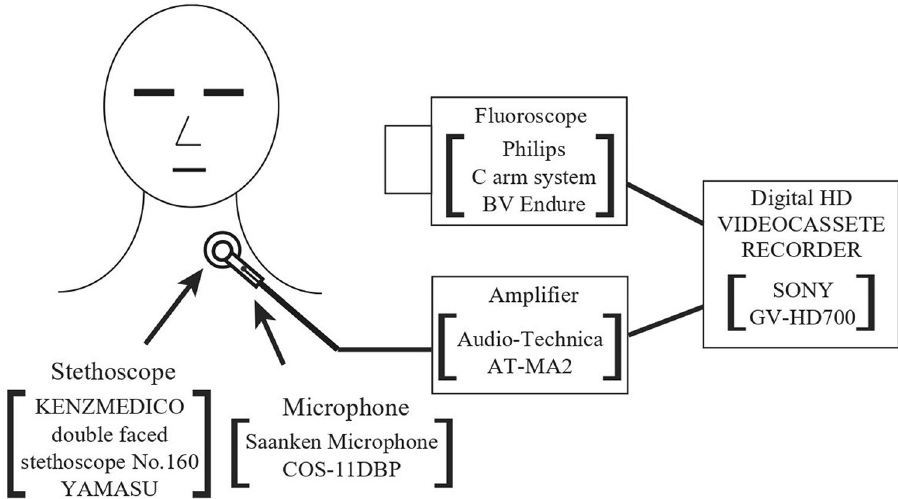
Figure 1. Detecting and recording system of swallow-related sounds. The diaphragm chest piece of a double- faced stethoscope connected to a short tube with an inserted microphone was attached to the site over the lateral border of the trachea immediately inferior to the cricoid cartilage. The detected acoustic signals were amplified, digitally converted with a 48-kHz sampling rate, and recorded with videofluorographic (VF) images into DVCAM tape through digital HD videotape